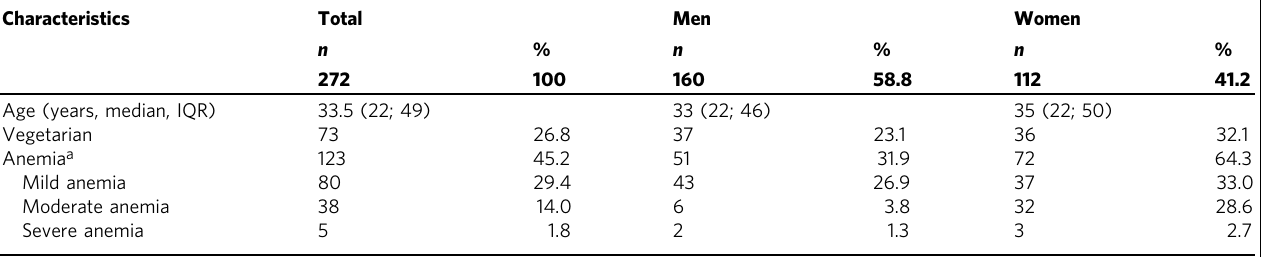
Table 1 Patients ’ characteristics including age, vegetarian status and anemia prevalence in the clinic-based sample. Characteristics